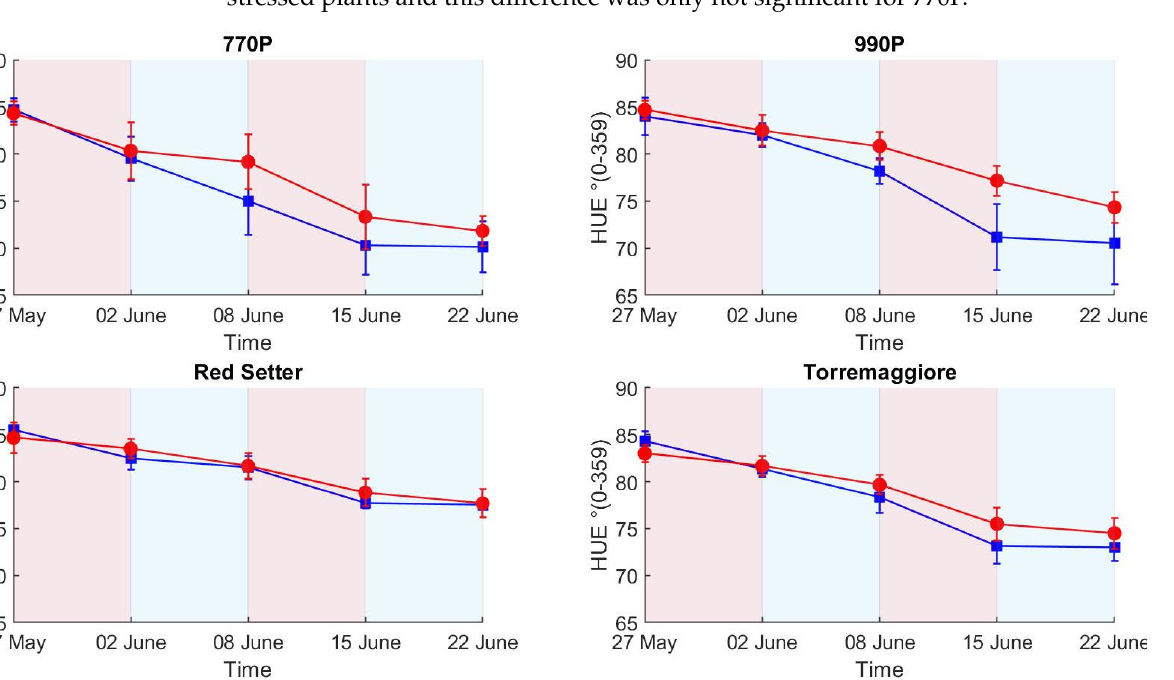
Figure 7. HUE index values in stressed and control treatments (red and blue lines and points, respectively) for the four genotypes. Each point reports the mean of six samples and the associated standard deviation.